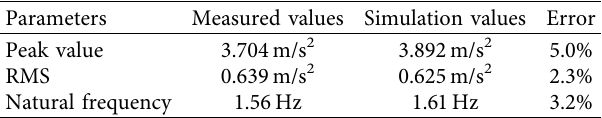
simulated Figure 23: PSD of the vibration signal when passing though obstacle platform. Table 13: The vertical acceleration measured at the position above the first road wheel compared with simulated